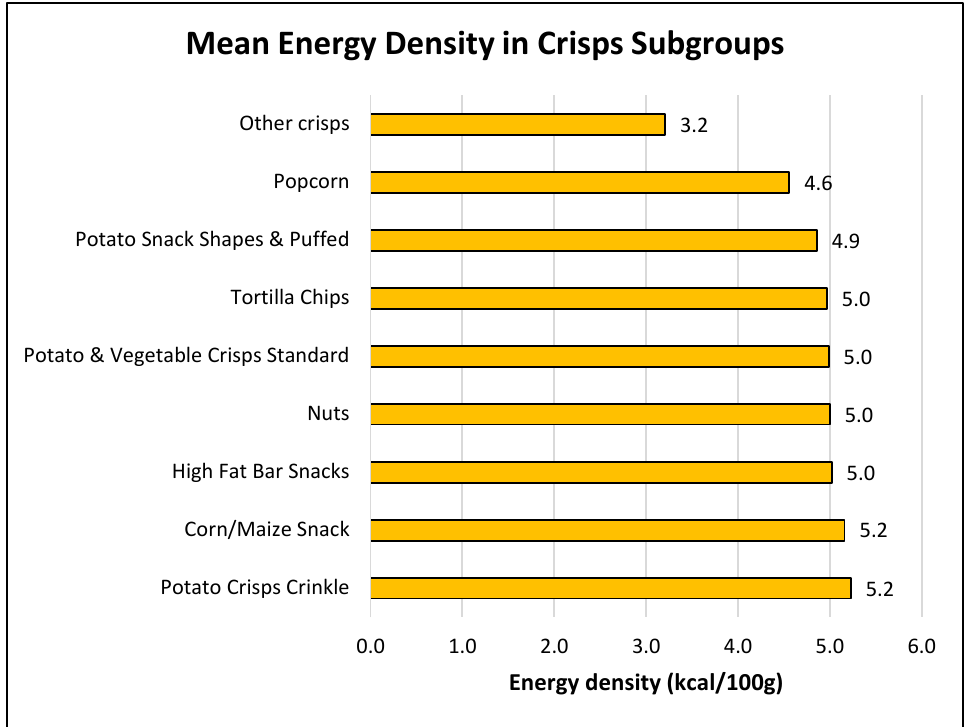
Figure A1. Mean energy density in food subgroups in each of the selected main food groups in the UK NDNS.